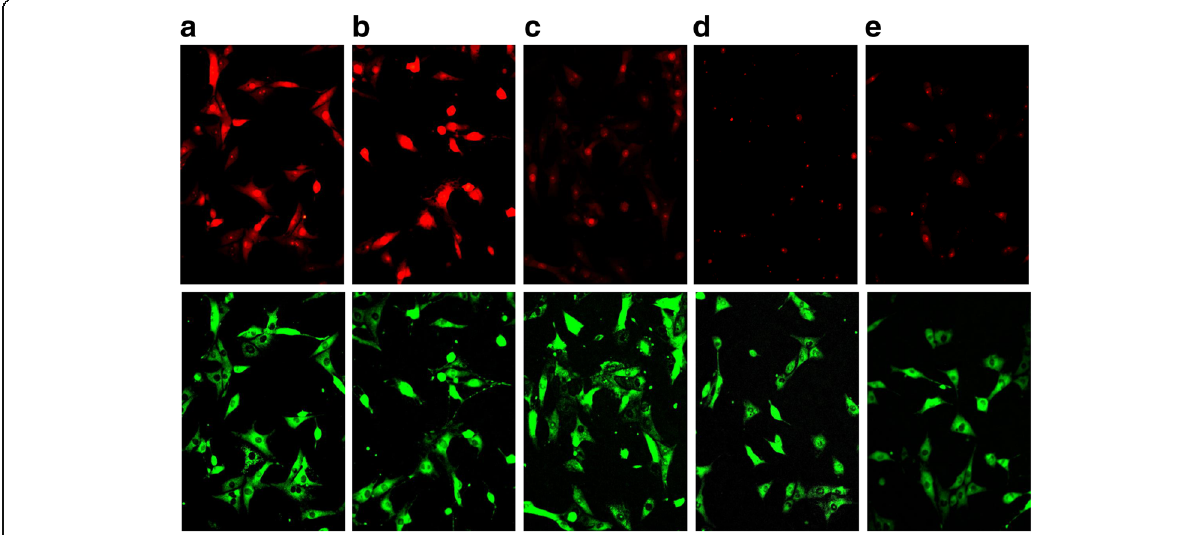
Fig. 4 Typical images demonstrating effect of propolis extracts on mitochondrial superoxide generation in C6 cells: a - control; b - 20 μ M of